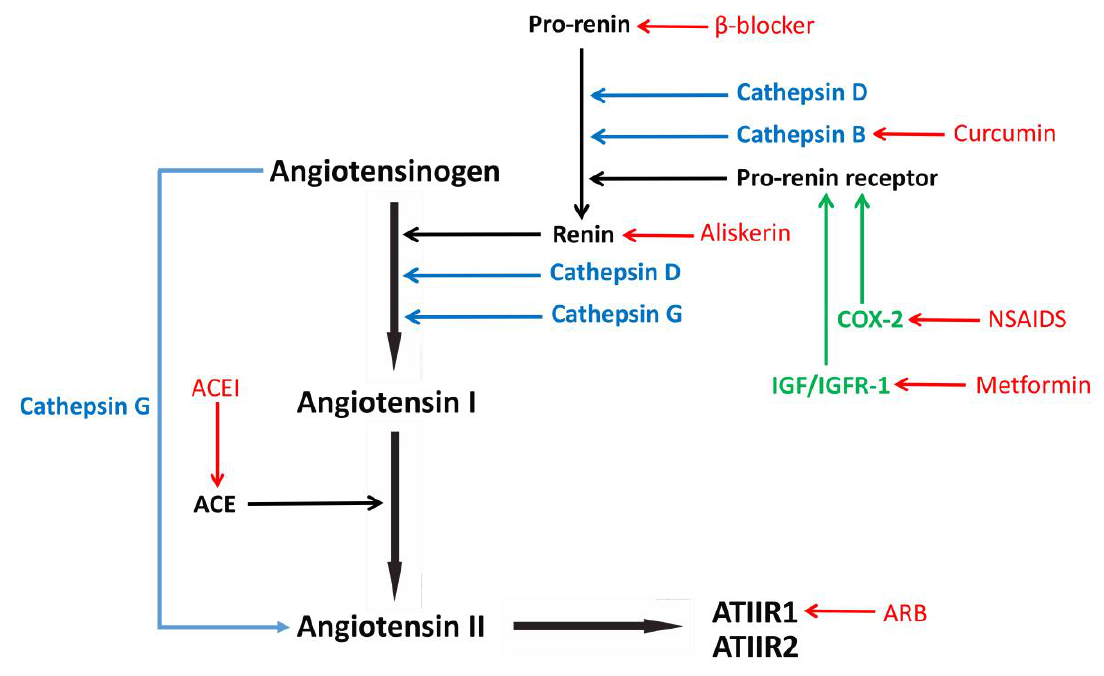
Figure 1. The renin-angiotensin system (RAS), its bypass loops and convergent signaling pathways, and medications that target key steps of these pathways. The classical RAS, highlighted in black, regulates blood pressure, stem cells and tumor development. Bypass loops of the RAS, highlighted in blue, involves enzymes such as cathepsins B, D and G provide redundancy, while other signaling pathways such as the COX-2 pathway and the IGF / IGFR-1 pathway, highlighted in green, converge on the RAS, to activate the pro-renin receptor. Key steps of the RAS and related pathways can be inhibited by commonly available medications, highlighted in red. Angiotensinogen (AGN) is physiologically synthesized and released by the liver and is cleaved by renin which is released by the kidneys, to form angiotensin I (ATI). Renin is formed following binding of pro-renin to the pro-renin receptor. Production pro-renin is reduced by β -blockers, and renin can be directly blocked using aliskerin. ATI is converted to angiotensin II (ATII) by angiotensin-converting enzyme (ACE), normally produced by the lungs. ACE can be blocked using ACE inhibitors (ACEI). ATII interacts with the G-protein coupled receptors ATII receptor 1 (ATIIR1) and ATII receptor 2 (ATIIR2), to restore homeostasis. ATIIR1 can be blocked using an ATIIR1 blocker (ARB). Cathepsins B and D are also renin-activating enzymes that convert pro-renin to renin. Curcumin inhibits the activities of cathepsin B. Cathepsin D also converts AGN to ATI, and cathepsin G converts ATI to ATII or AGN directly to ATII. The COX-2 pathway and the IGF / IGFR-1 pathway can be blocked using non-steroidal anti-inflammatory drugs (NSAIDS) and metformin, respectively.